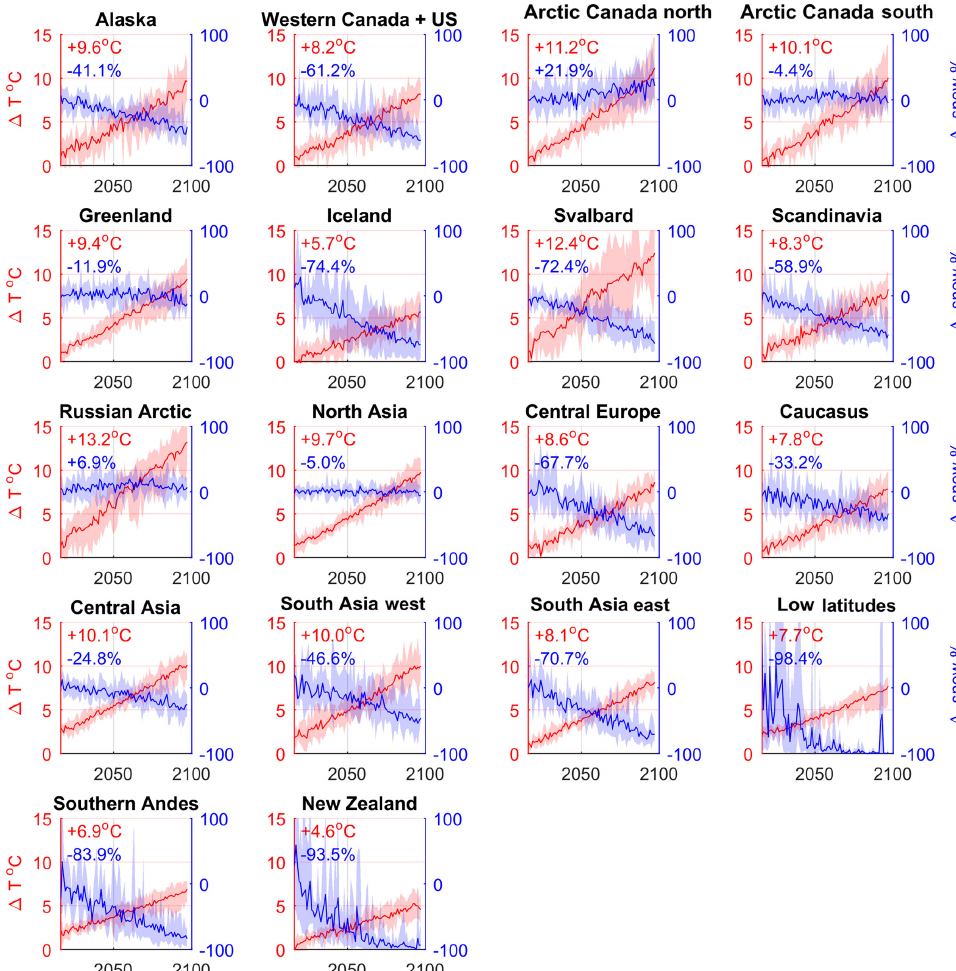
Figure 9. Regional temperature and snowfall changes relative to the present day (2011–2015) from the HadGEM3-A ensemble over glaciated grid points. The ensemble mean is shown in the solid line and the range of model projections are shown in the shaded